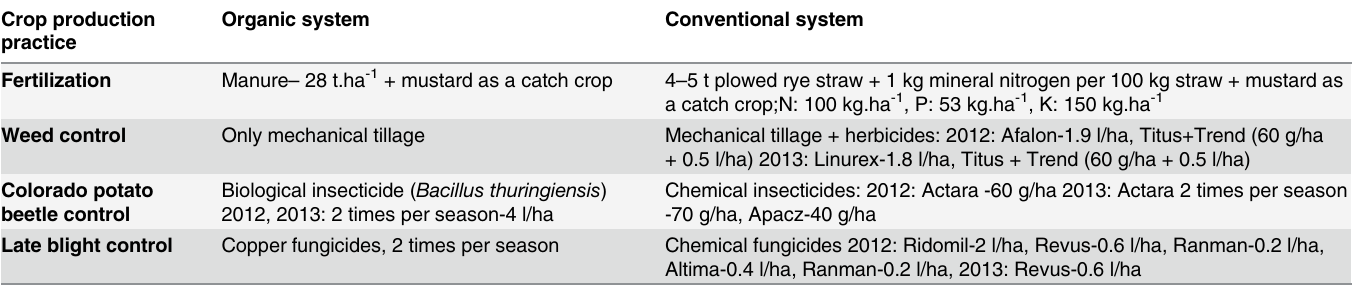
Table 1. Agronomic inputs in organic and conventional systems.